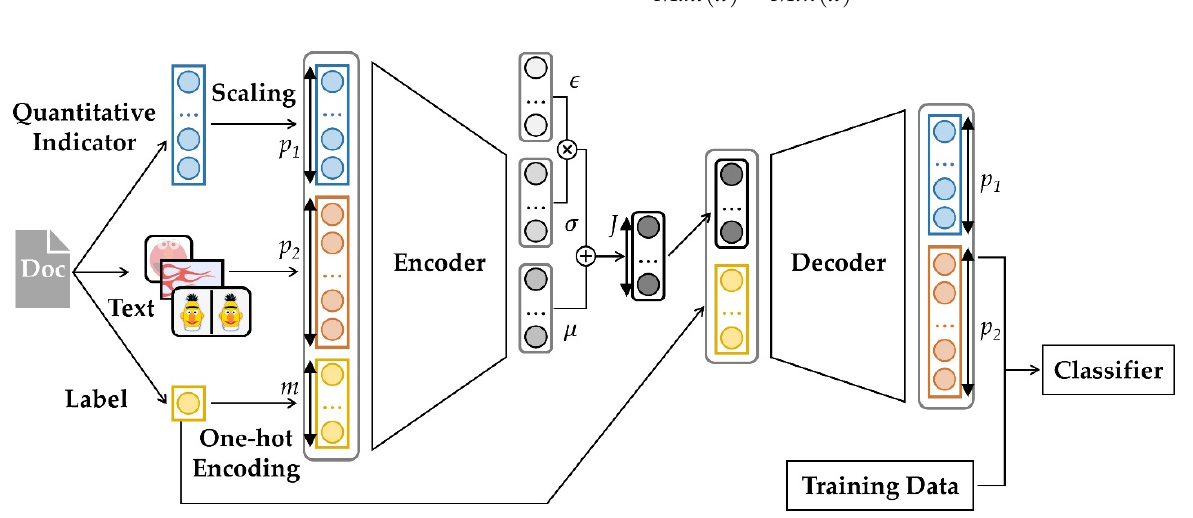
Figure 1. Architecture of the proposed methodology.